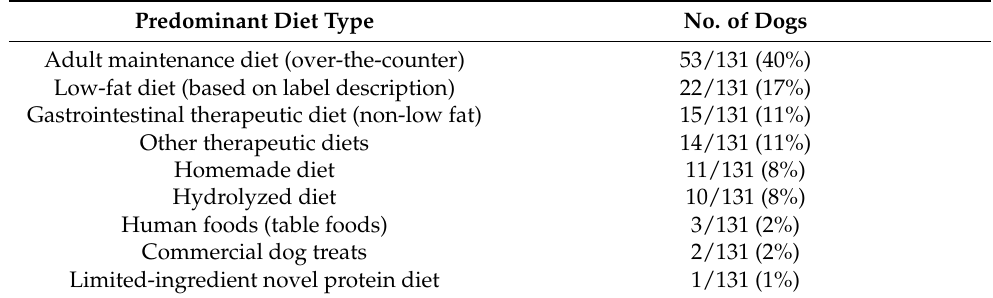
Table 7. Predominant diet type reported in survey data from dogs with a serum cPLI concentration ≥ 400 µ